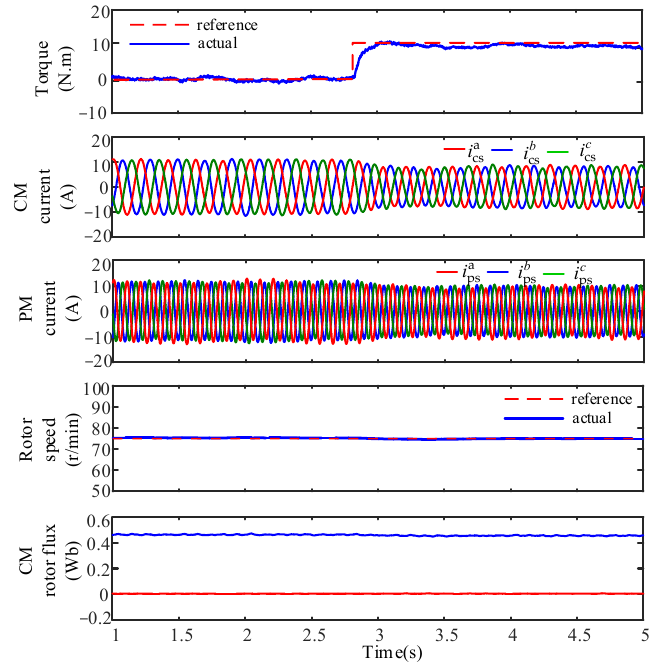
Figure 21. Experimental results when step disturbance is applied.